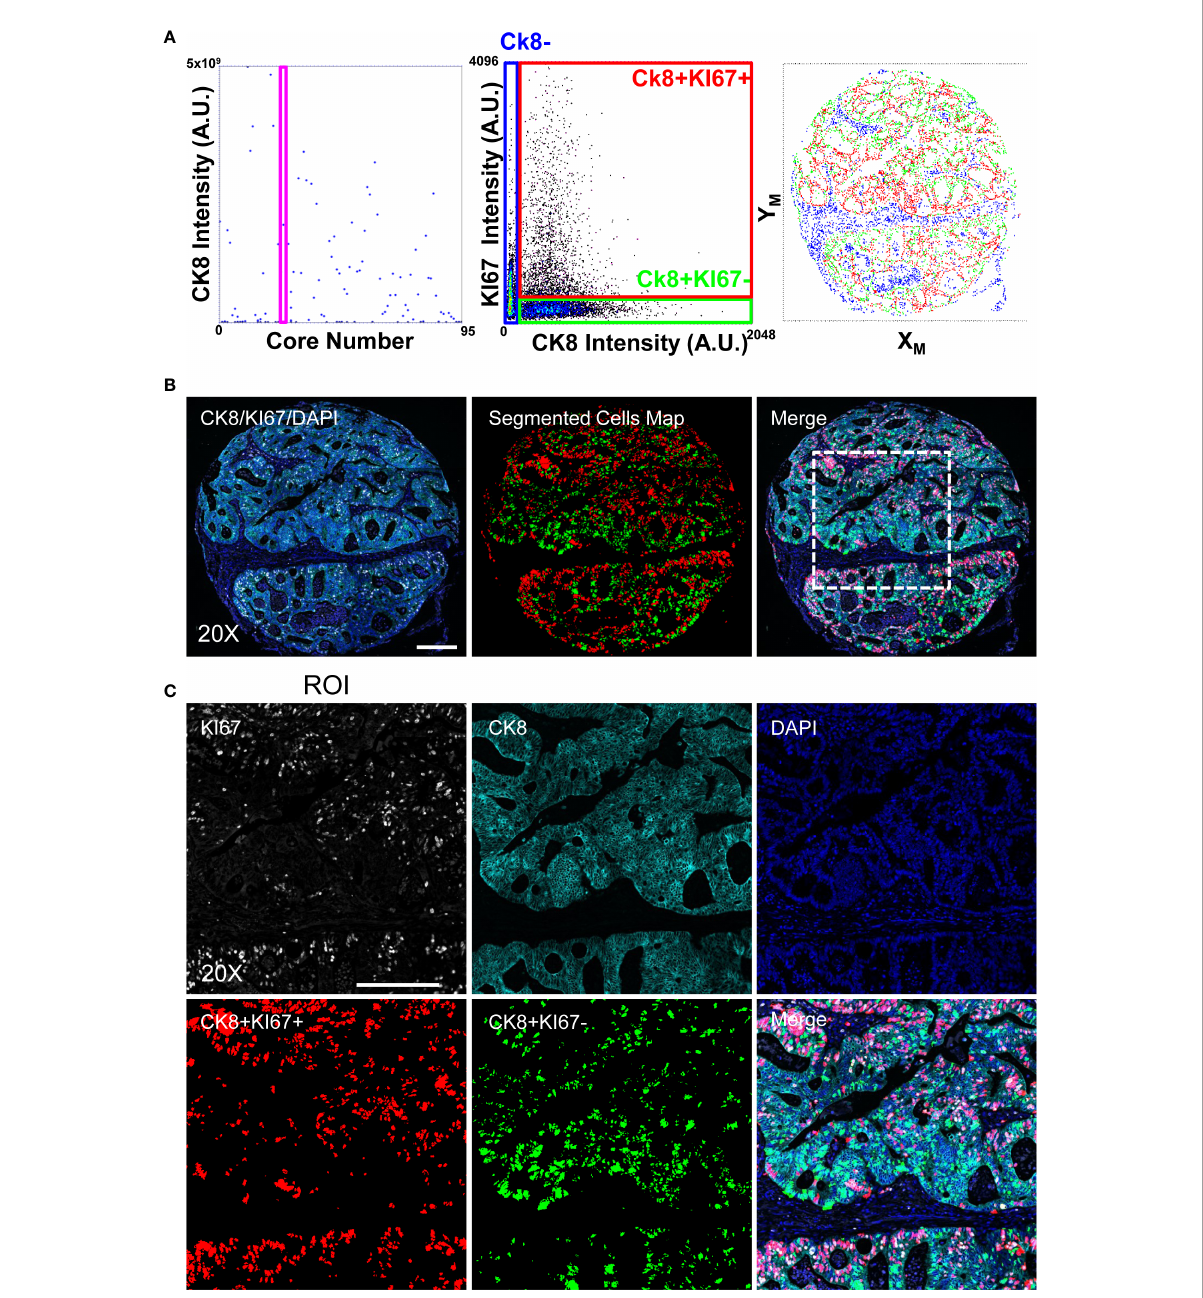
FIGURE 3 Image-Cytometry Analysis Work fl ow on a TMA. Single cell resolved images of single cores, collected according to the discussed protocol, are segmented and statistics of single cores calculated to select targets enriched in the epithelial regions (CK8+). Panel (A) : Targeted Cores (the shown representative core is identi fi ed by the Magenta Rectangle graph on the left) are then reanalyzed by segmenting cells in the CK8 positive area, reporting the expression of the KI67 proliferation marker (middle graph) to de fi ne the population of interest, i.e. proliferating (CK8+KI67+) and quiescent (CK8+KI67-) epithelial cells. Image coordinates of the cells (right graph) are then re-converted into microscope stage positions for the next acquisition. Panel (B) : 20X single cell resolved stitched image of the targeted core. Acquired channels (left), segmented cells (middle; CK8+KI67+(Red) and CK8+KI67-(Green)) and the resulting merge (right) are shown. The highlighted square identi fi es the ROI magni fi ed in C. Scale bar: 200 m m. Panel (C) : Enlarged views at full resolution of the KI67, CK8, DAPI fl uorescence channels, together with segmented masks of the CK8+KI67+(Red) and CK8+KI67-(Green) cell populations. Scale bar: 200 m